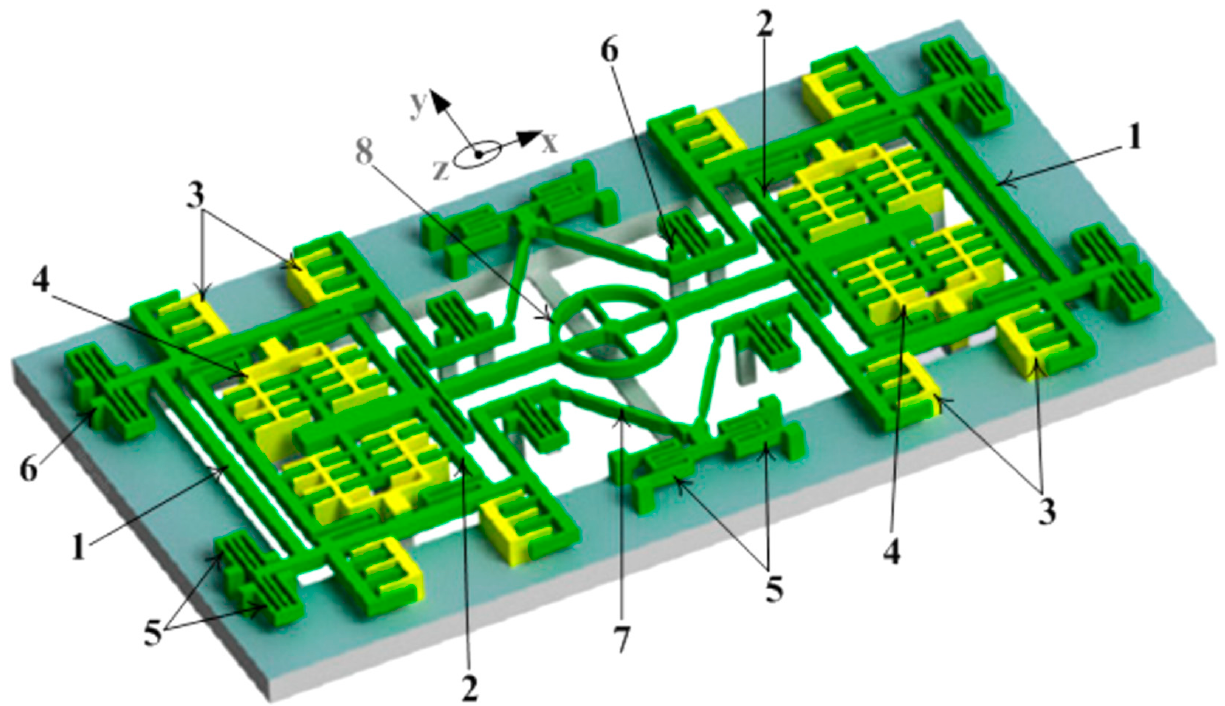
Figure 11. Schematic representation of the z -axis freestanding gyroscope [43]: 1—External frame, 2—internal frame, 3—drive electrodes, 4—sense electrode, 5—spring beams, 6—support anchors, 7—linear beams, and 8—circular rotating ring.